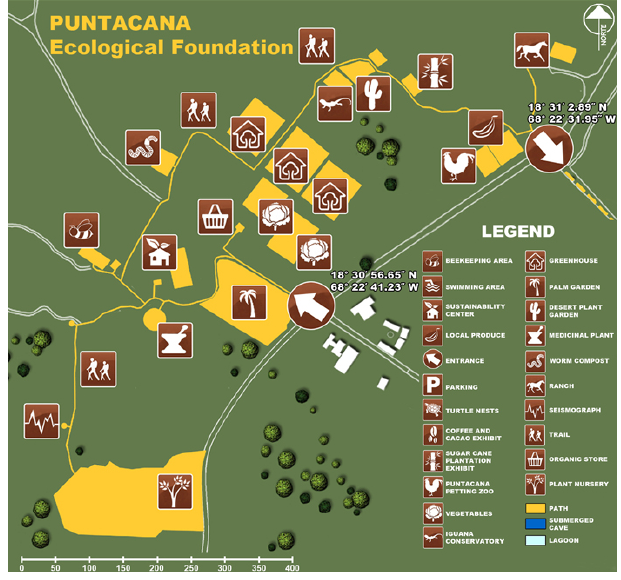
Fig. 5 . Map of Ecological Foundation facilities.